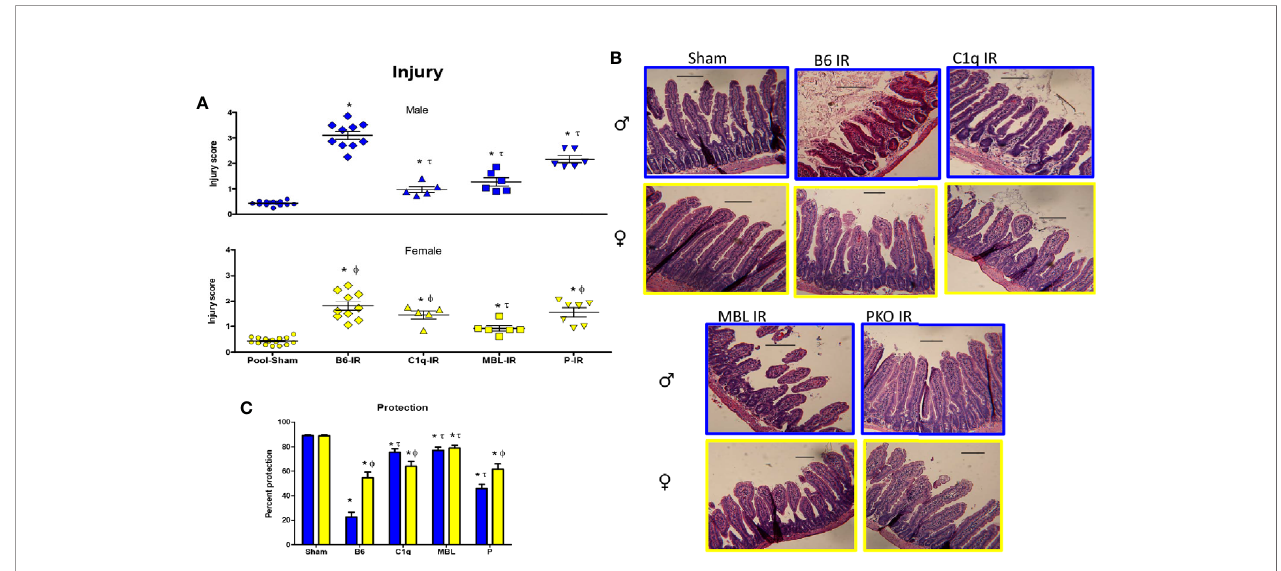
FIGURE 4 | Intestinal IR-induced tissue damage was protected in complement de fi cient mice in a sex-dependent manner. C57B6L/J WT, C1q - / - , MBL - / - , and P - / - mice were subjected to Sham and IR treatment with 120 min reperfusion and mid-jejunum sections H&E stained and scored for mucosal injury (75-150 villi per section). (A) Individual injury scores of Pooled Sham (Sham), or IR treated C1q -/- , MBL -/- or P -/- male (blue bars) and female (yellow bars) mice are shown. (B) Representative microphotographs of H&E stained section (200x) of Sham or IR treated C1q -/- , MBL -/- or P -/- male (blue outline) and female (yellow outline) mice are presented. Bar = 40 m m. (C) Percent protection was calculated by the following equation, (1-(Injury score/Max injury of 4.0)*100). * indicates signi fi cant difference between IR treatment and Sham within the same sex (P ≤ 0.05), as determined by 1-way ANOVA with Newman Keuls post-hoc test; Ф indicates signi fi cant difference between sexes in the same point same treatment (P ≤ 0.05), as determined by unpaired t-test; t indicates signi fi cant difference between same sex IR compared to WT IR (P ≤ 0.05), as determined by 1-way ANOVA with Newman Keuls post-hoc test. Each bar is representative of 7-12 mice per